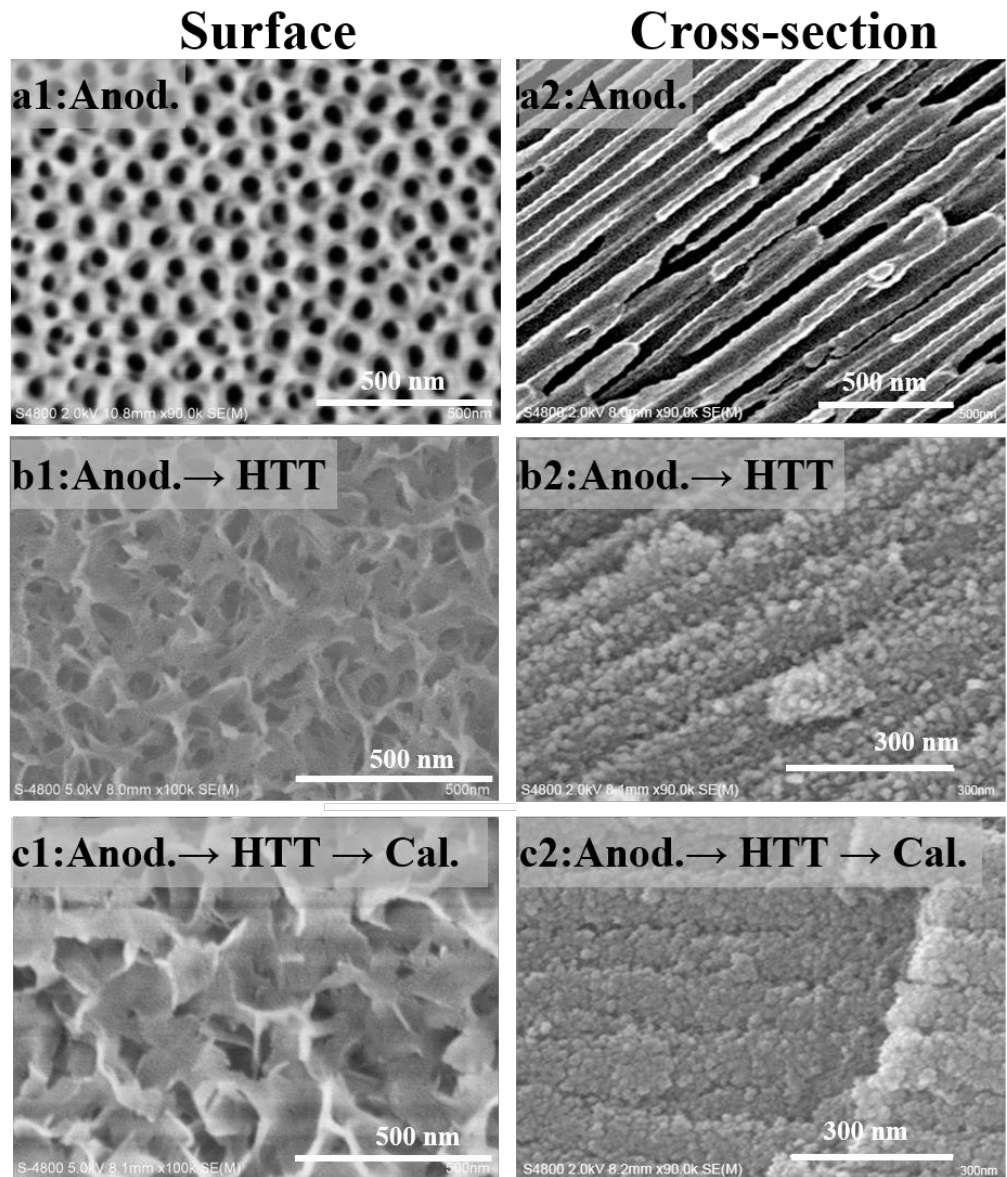
Figure 5. SEM images of the PAA materials with different post-treatments.